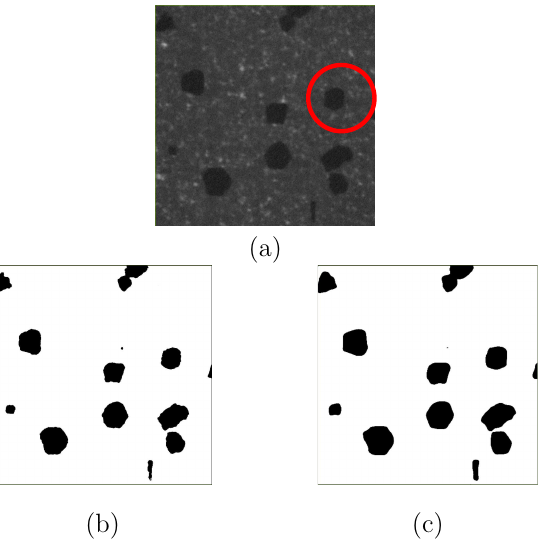
Fig. 12: Image segmentation for diamonds: (a) an original CT image; Figure 12. Image segmentation for diamonds: ( a ) an original CT image; ( b ) median filter with an (b) median filter with an aperture linear size of 7; (c) U-Net (CNN in aperture linear size of 7; ( c ) U-Net (CNN in ML). ML).